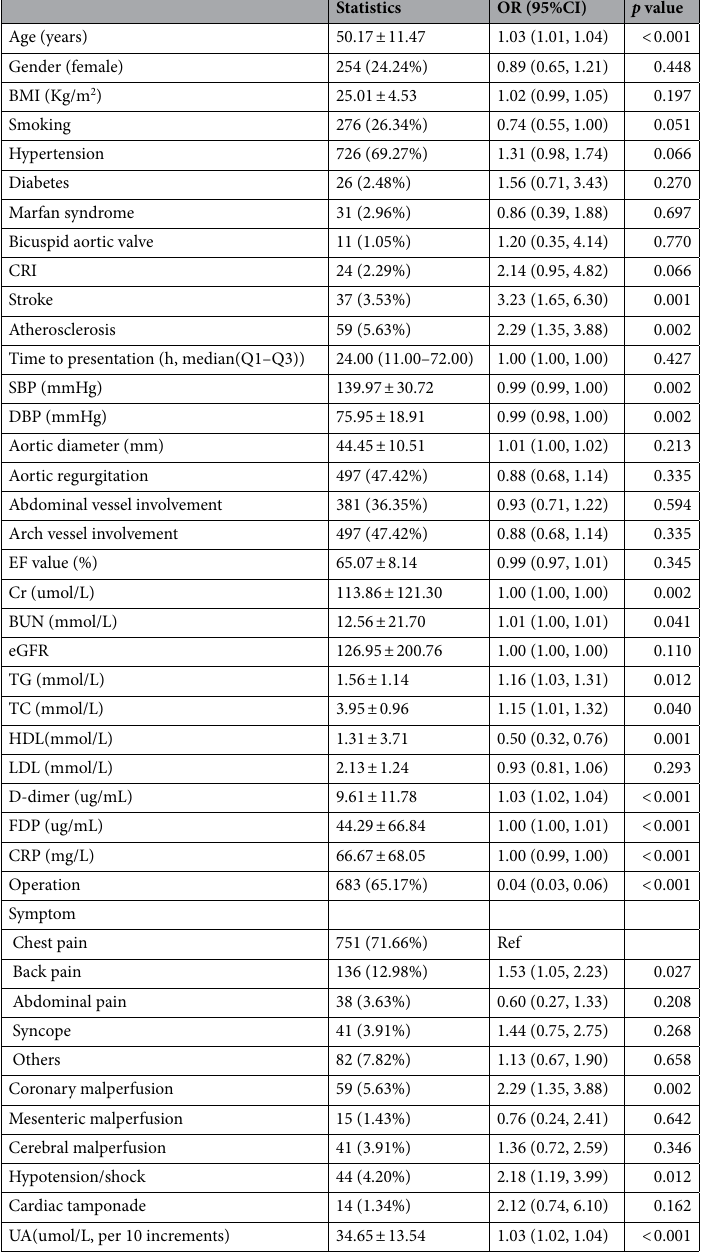
triglyceride, TC total cholesterol, HDL high-density lipoprotein, LDL low-density lipoprotein, FDP fibrinogen and fibrin degradation products, CRP C-reactive protein, CRI chronic renal insufficiency, EF ejection